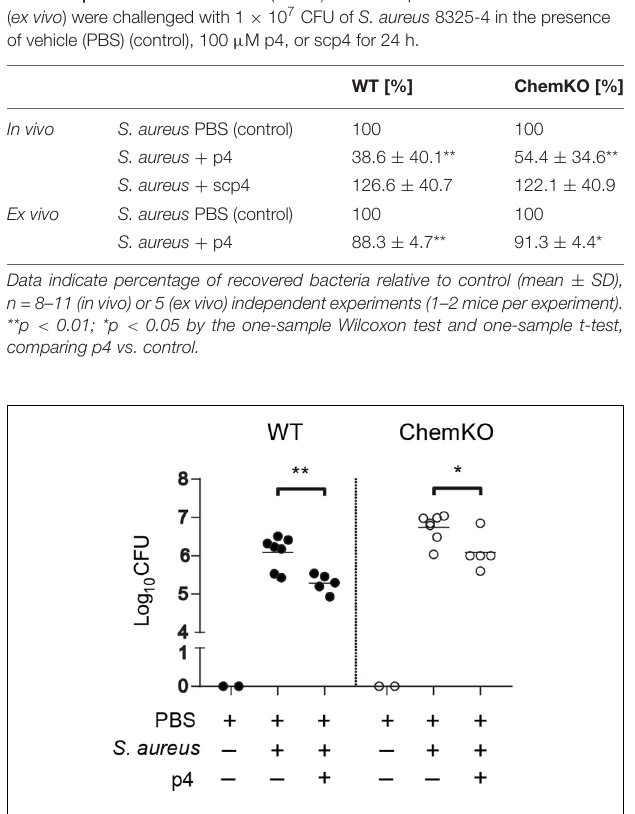
FIGURE 3 | p4 is bactericidal ex vivo . Skin biopsies from WT and ChemKO mice were challenged with 1 × 10 7 CFU of S. aureus 8325-4 in the presence of 100 µ M p4 or vehicle (PBS). Data points indicate the CFU of bacteria recovered from the skin surface 24 h after application of bacteria, with each data point representing one cavity and a horizontal line indicating the mean value in each group; n = 5 (1–2 mice per group). ** p < 0.01; * p < 0.05 by unpaired t